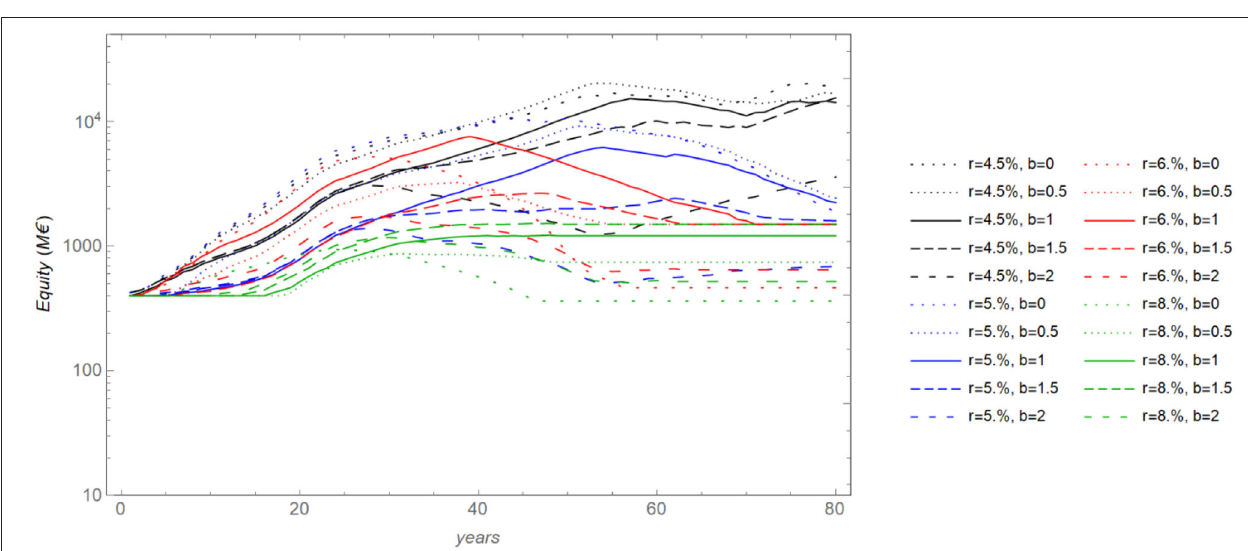
FIGURE 5 | Equity for the 20 companies in a base case run [ f = 30% and i = 400M e . f is the fraction of an investment financed by a company’s own capital and i is the initial capital in a company’s bank account]. Companies with lower hurdle rates r dominate, except those that expect the highest carbon tax, i.e., have the greatest expectation parameter b. Companies that have accurate tax expectations perform well in this perspective for all hurdle rates.